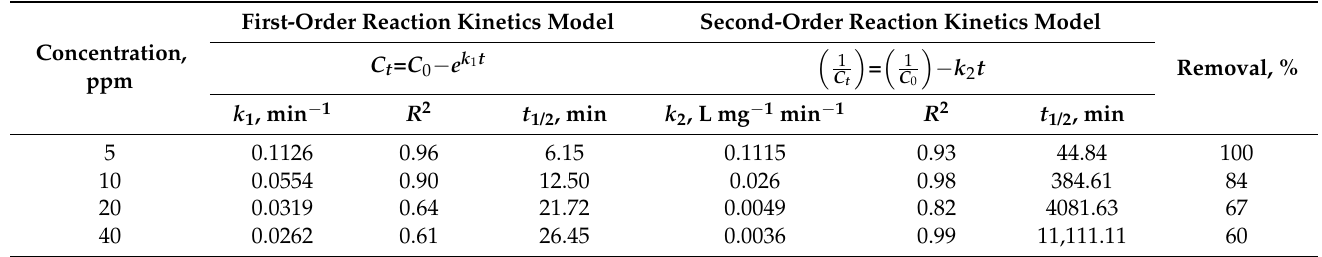
Table 3. Kinetic parameters of the Reactive Blue 4 wastewater oxidation via the PANI-MWCNTs under different concentrations